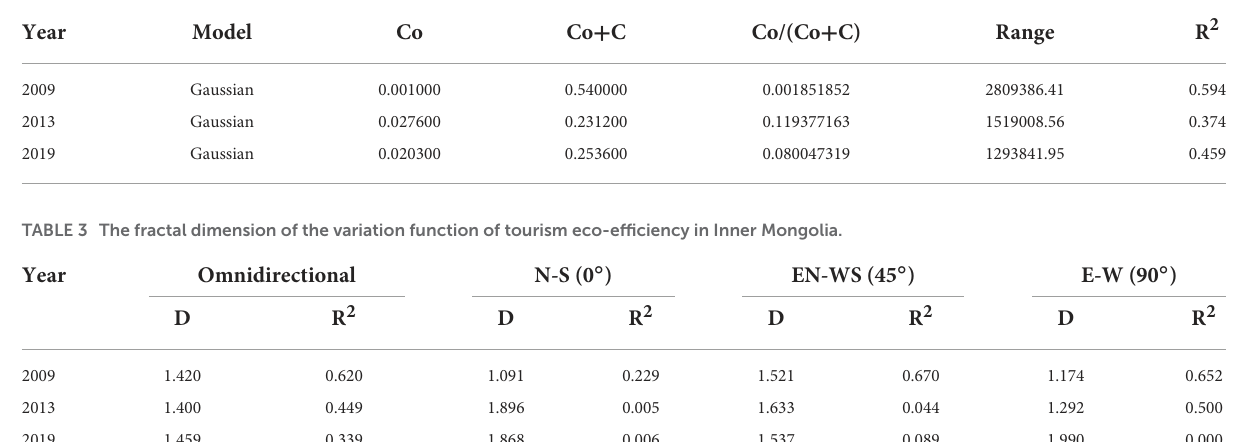
TABLE 2 Fitting parameters of the variation function of tourism eco-efficiency in Inner Mongolia.